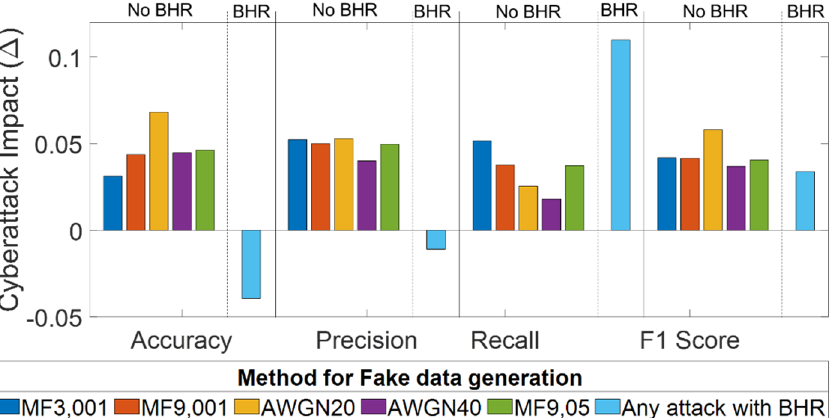
Figure 7. Metric reduction versus BCI performance metrics for each cyberattack method.